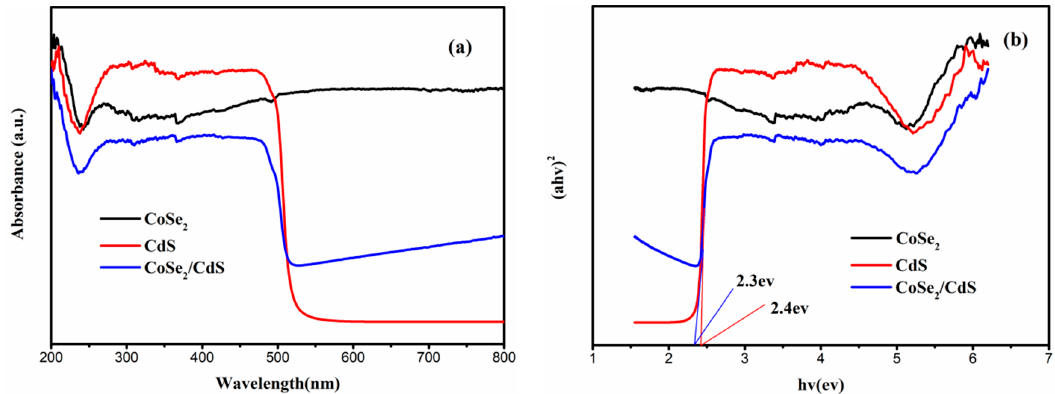
Figure 3. ( a ) The UV–VIS DRS of pure CdS, CoSe 2 and CoSe 2 /CdS. ( b ) The forbidden band of CdS, CoSe 2 , and CoSe 2 /CdS.